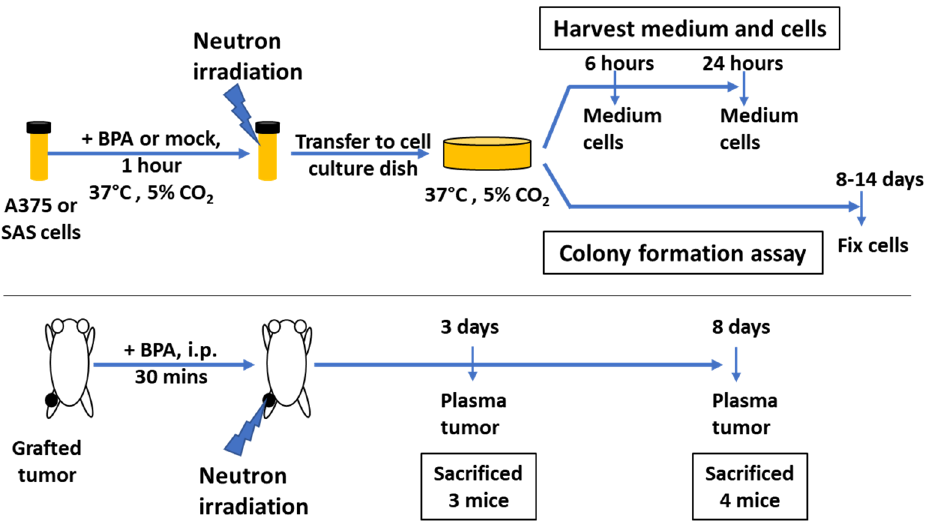
Figure 1. Schematic diagram of cell and mouse irradiation experiments. Cell suspensions were subjected to neutron beam irradiation in the presence and absence of BPA. Mice were irradiated with neutron beam. The SAS cells were subcutaneously grafted to left hind legs, administered with either BPA or mock treatment, and irradiated with neutron beam.